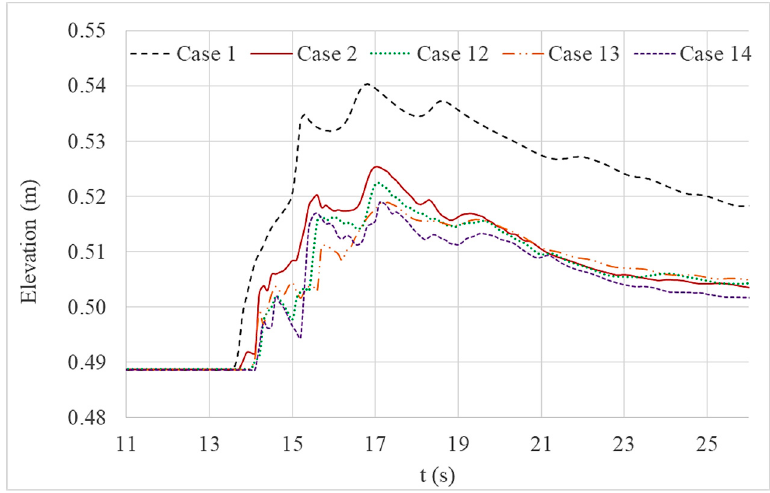
Figure 15. Comparison of water level variations at location D.